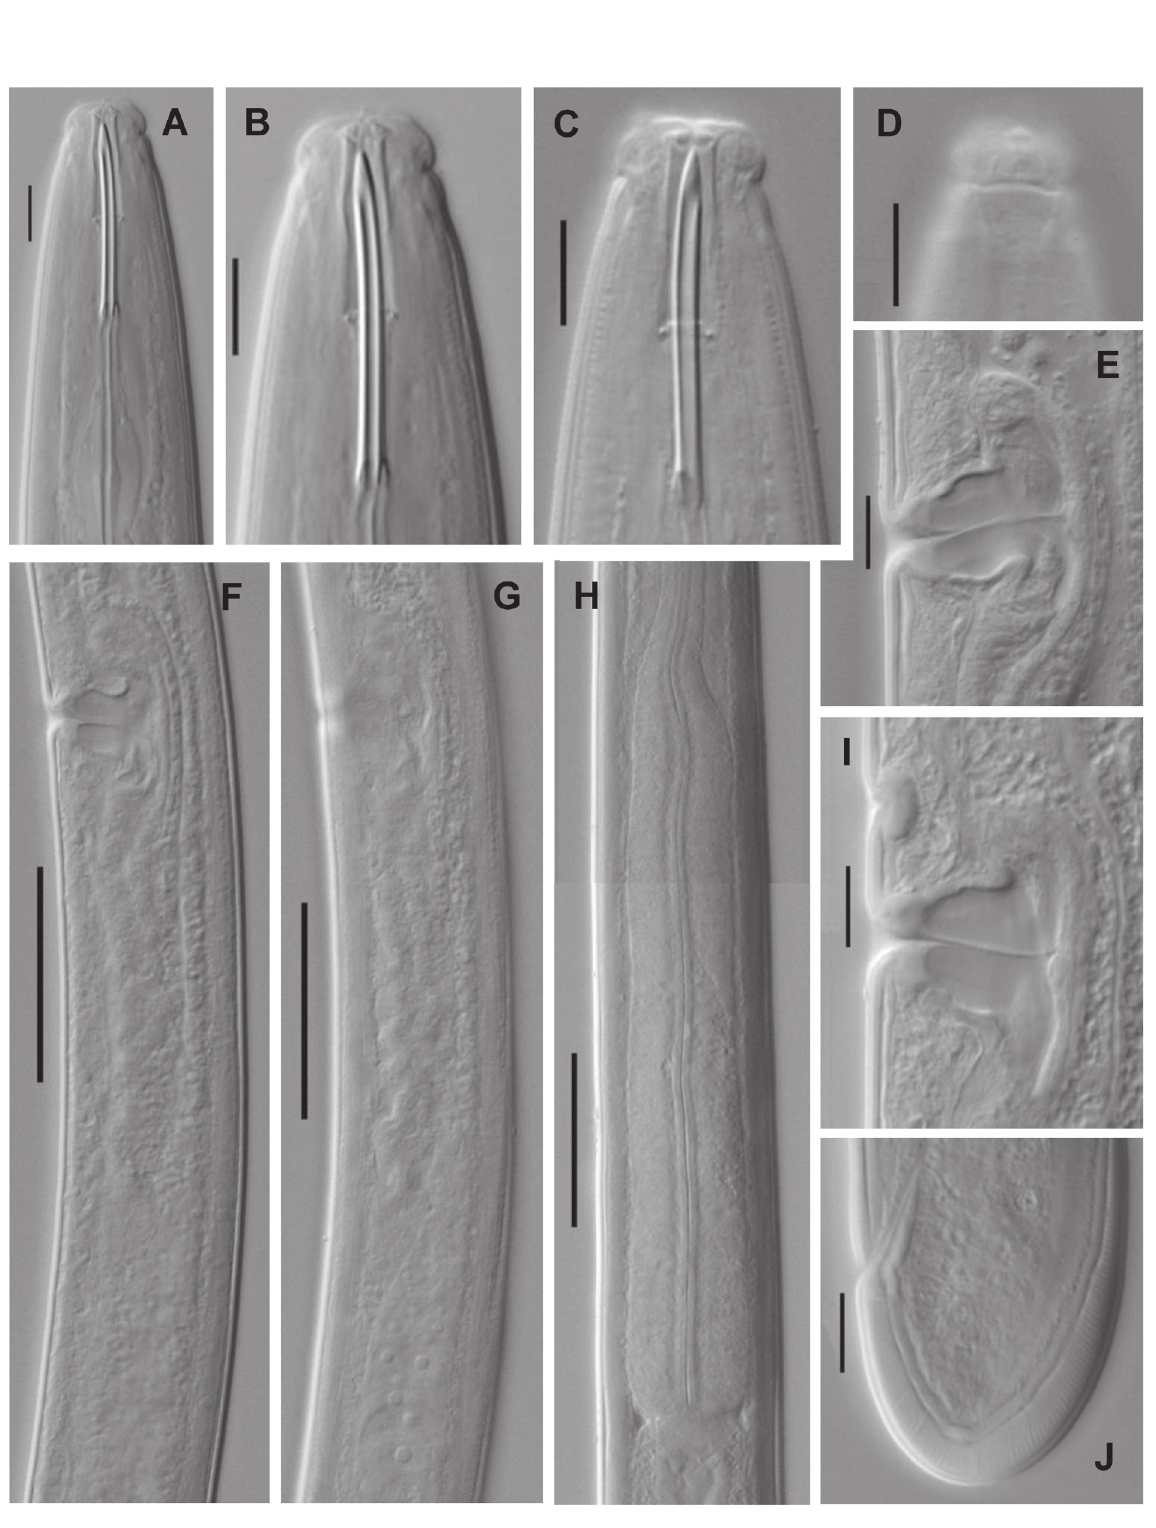
Fig. 6. Pungentus silvestris (de Man, 1912) (♀, LM). A-C . Anterior region in median lateral view. D . Lip region in surface lateral view. E , I . Vagina and pre-vulval uterine sac. F-G : Posterior genital branch. H . Pharyngeal expansion. J . Caudal region. (Scale bars : A-E, I, J = 10 µm; F-H = 50